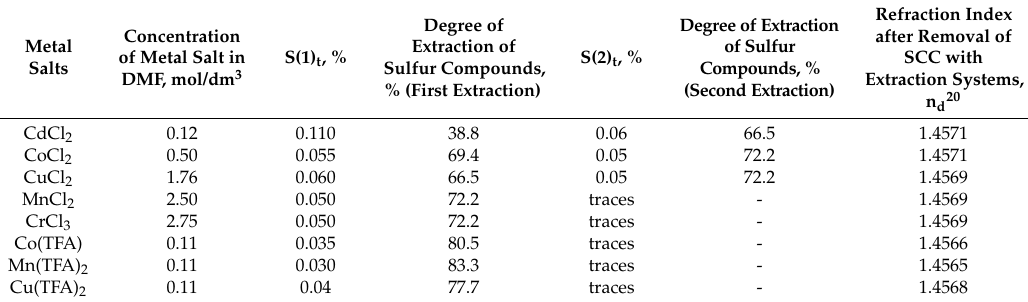
Table 1. Results of extraction of sulfur compounds from the diesel oil fraction (200–350 ◦ C) with solutions of chlorides and TFA metals in DMF. The total sulfur content (St) in the initial sample is 0.22%, n d20 (DT) = 1.4655. S tot content in the initial sample after treatment with DMF is 0.12%. The extraction time is 30 min. The temperature is 25 ◦